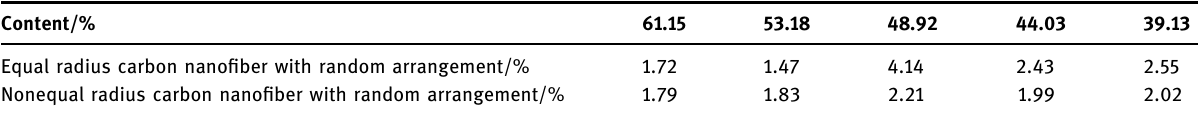
Table 1: The average values of relative mean deviation of scattering factor in band of 2.5 – 15 µm